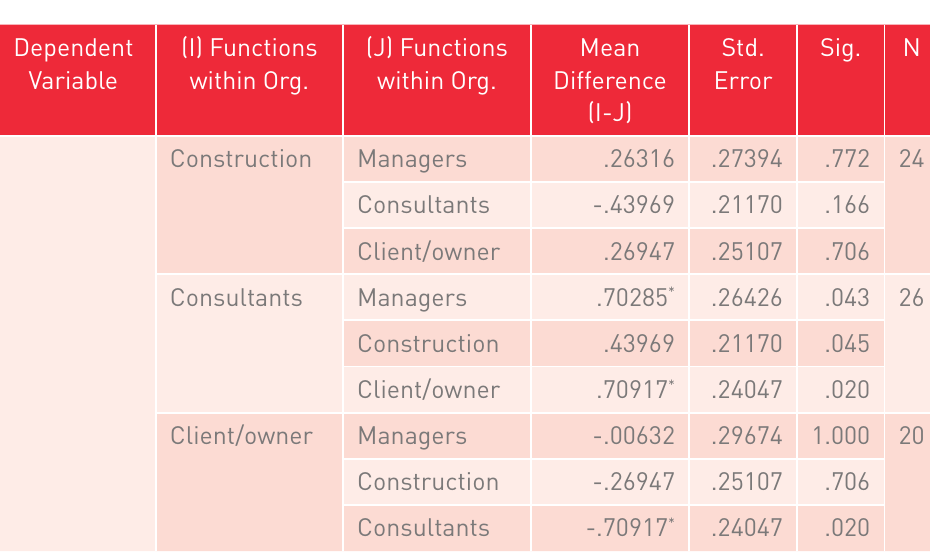
FINDINGS FROM THE INTERVIEWEES